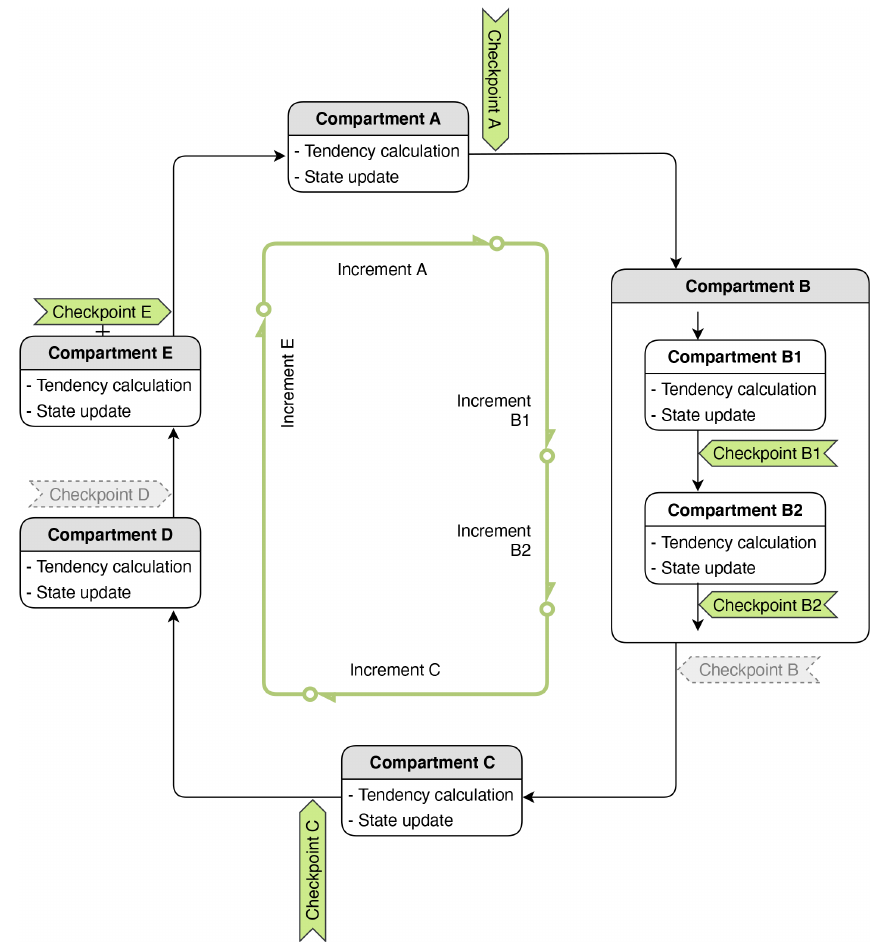
Figure 2. A schematic showing a time step of model simulation involving five hypothetical code compartments, A to E, either resolved or unresolved by the model’s computational mesh, that are numerically coupled using isolated sequential splitting (see Sect. 2.2). Also shown are various tags of locations (referred to as checkpoints, see Sect. 3.1) within a time step that are introduced to facilitate diagnostics using the new tool. When the tool is used in a simulation, some checkpoints are activated (i.e., selected by the user and indicated in green here), and others are inactive and indicated in gray. No information is monitored at inactive checkpoints. The green lines with a circle on one end and an arrowhead on the other end depict how increments of model variables are defined. Further details can be found in Sects. 2.2 and